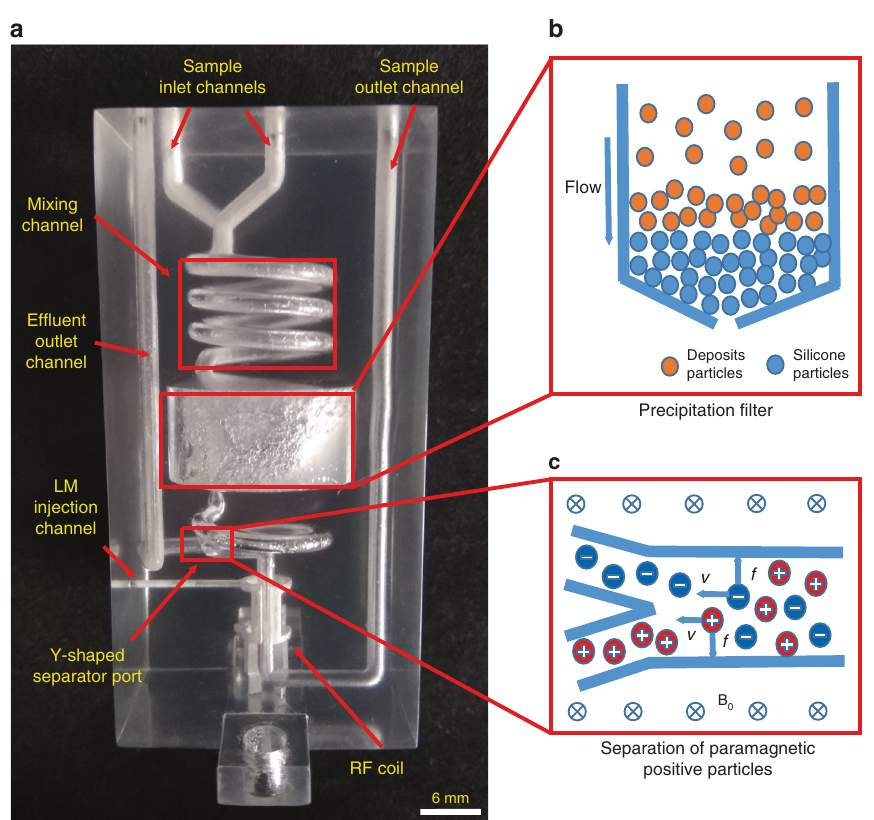
Fig. 5 Inner structures and separation principles of the CFSP. a The internal structure of the CFSP. b The principle of in situ fi ltration and separation of paramagnetic particles. c The principle of the Lorentz force separation of paramagnetic ions under a strong magnetic fi